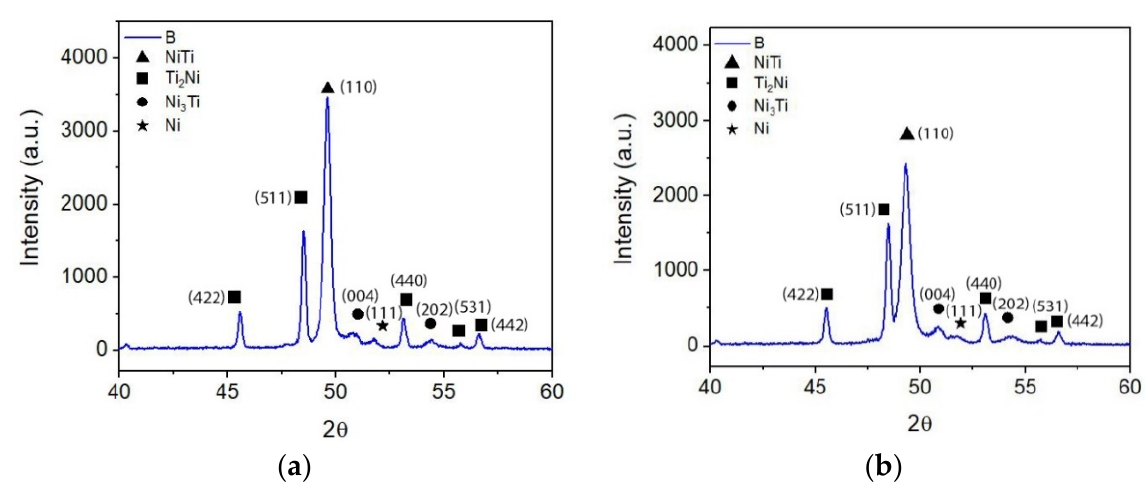
Figure 7. X-ray diffractograms of 3D object from filament B. ( a ) top, ( b ) bottom.